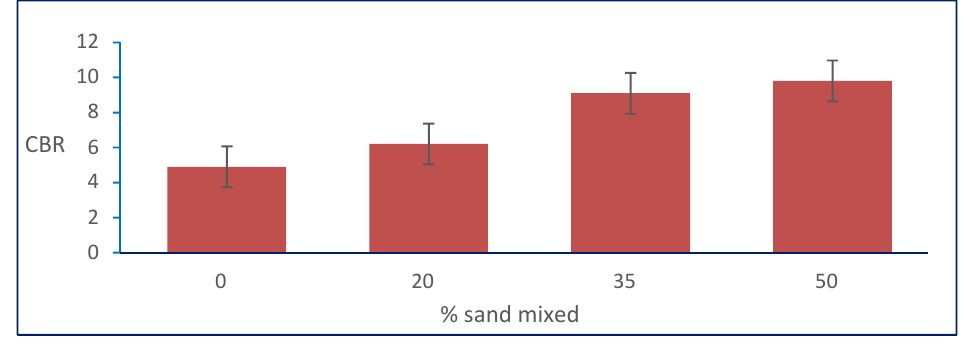
Figure 12. Effect of sand on CBR.